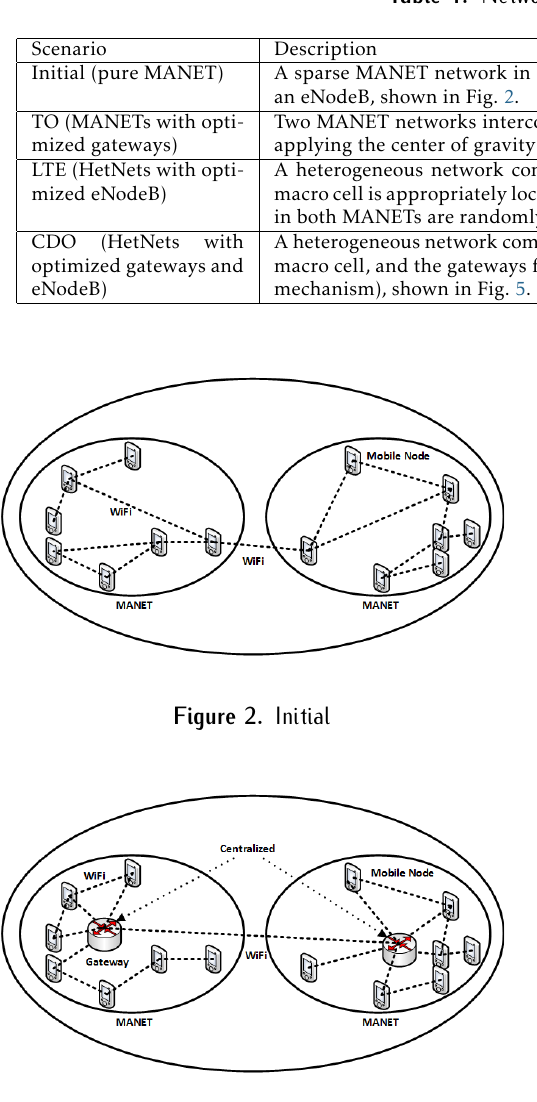
Figure 3. Topology